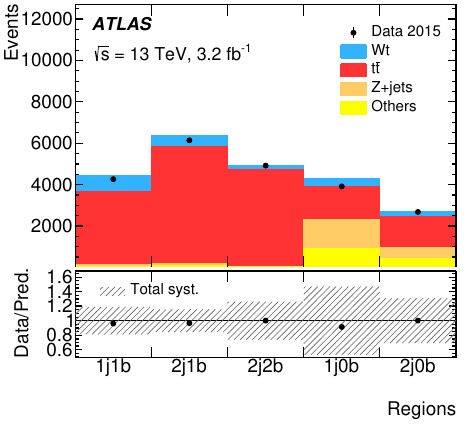
Figure 3. Expected event yields for signal and backgrounds with their total systematic uncertainty (discussed in section 8) and the number of observed events in the data are shown in the three (cid:12)t regions ( 1j1b , 2j1b , and 2j2b ) and the two additional regions ( 1j0b and 2j0b ). The signal and backgrounds are normalised to their theoretical predictions, and the error bands represent the total systematic uncertainties which are used in this analysis. The upper panel gives the yields in number of events per bin, while the lower panel gives the ratios of the numbers of observed events to the total prediction in each bin.